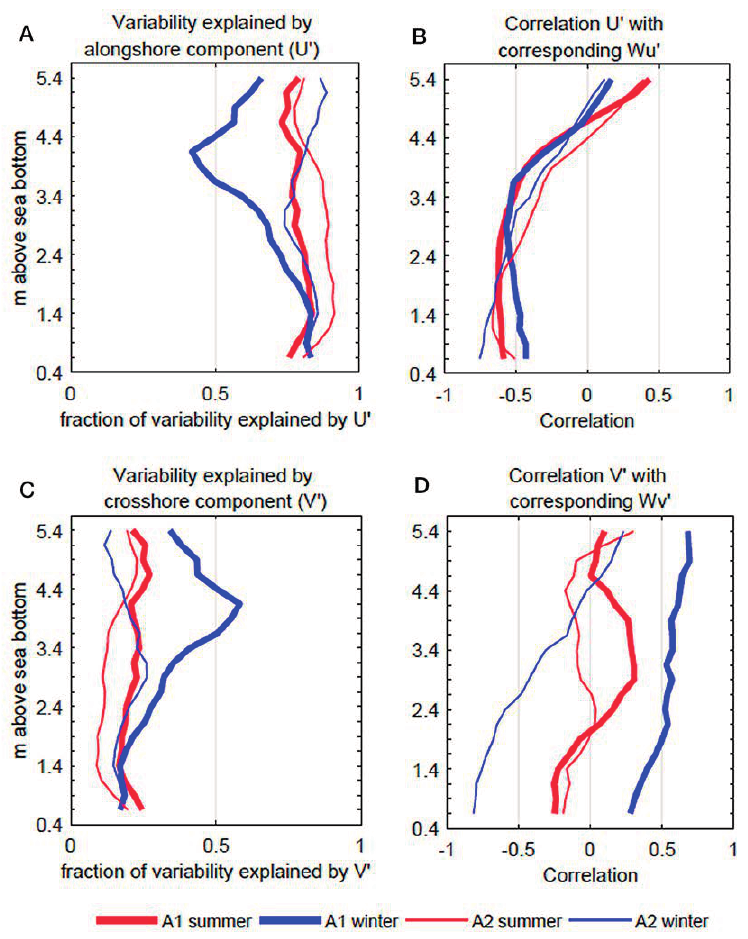
Fig 4. – Left hand side: profiles showing the fraction of variability explained by alongshore (A) and cross-shore (C) components at A1 (thick line) and A2 (thin line) in summer (red) and winter (blue). Right hand side: profiles showing the same components but for the correlation coefficients of each water current layer with wind (panels B